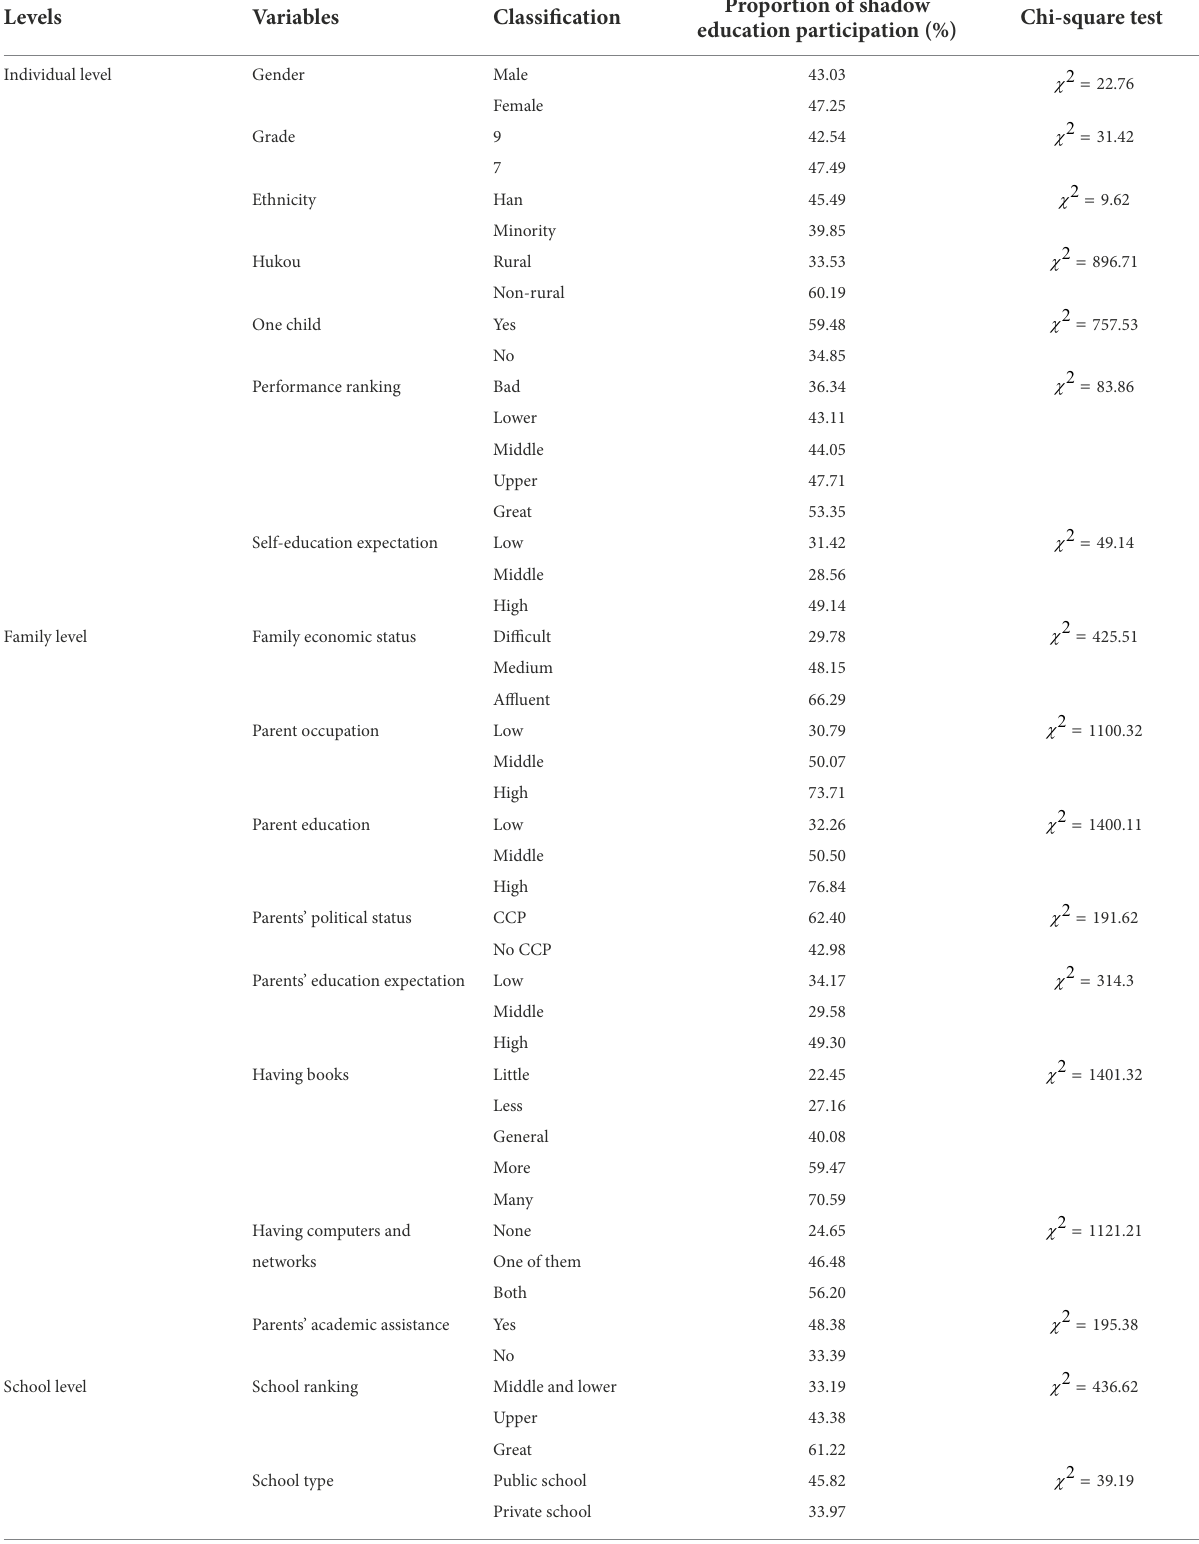
TABLE 2 Heterogeneity difference of shadow